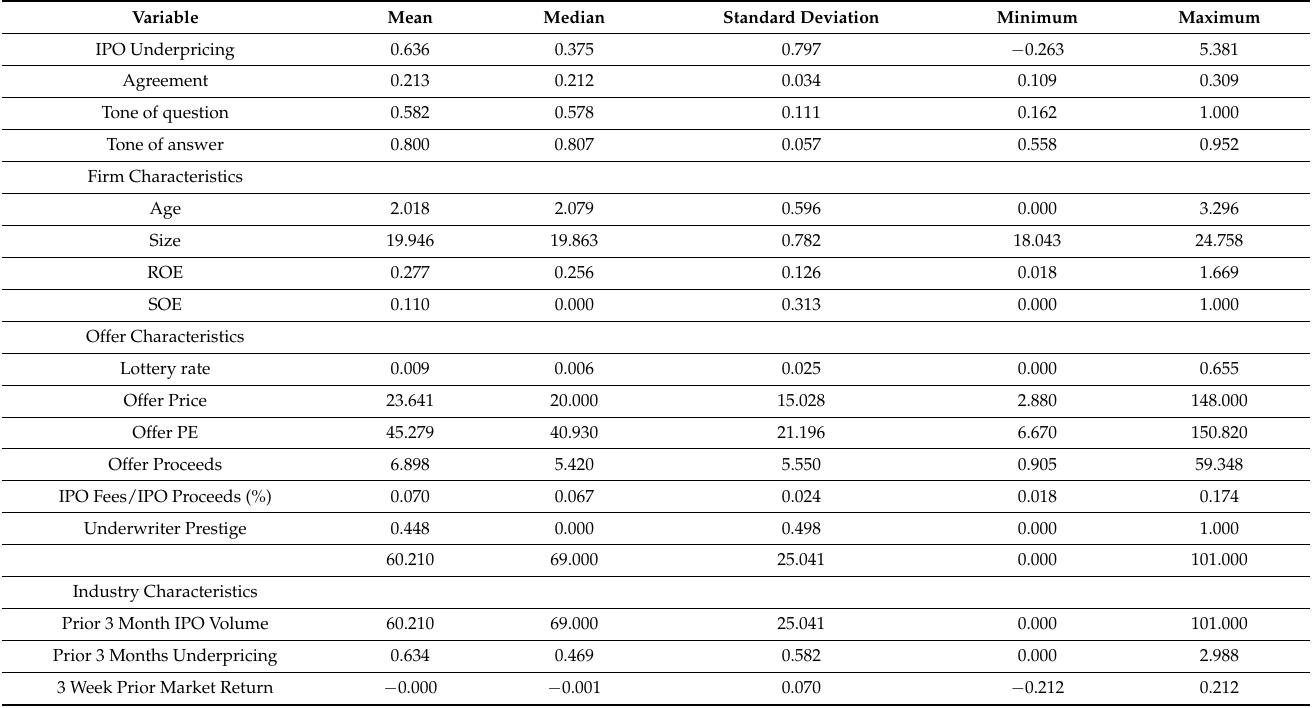
Table 2. Summary Statistics of Sample Variables. This Table reports the summary statistics for our sample of 980 firm observations drawn from the SME and ChiNext on the ShenZhen Stock Exchange. The sample spans 2004 to 2012. Reported are the means, medians, standard deviation, minimum and maximum values for each of the variables used within our analysis. IPO Underpricing is the common definition that uses First-day Return (Underpricing) as the IPO initial return, which is the percentage change in price from the IPO offer price to the closing price on the first day of trading. Agreement is the Jaccard similarity of investor questions and management answers on the IPO Net